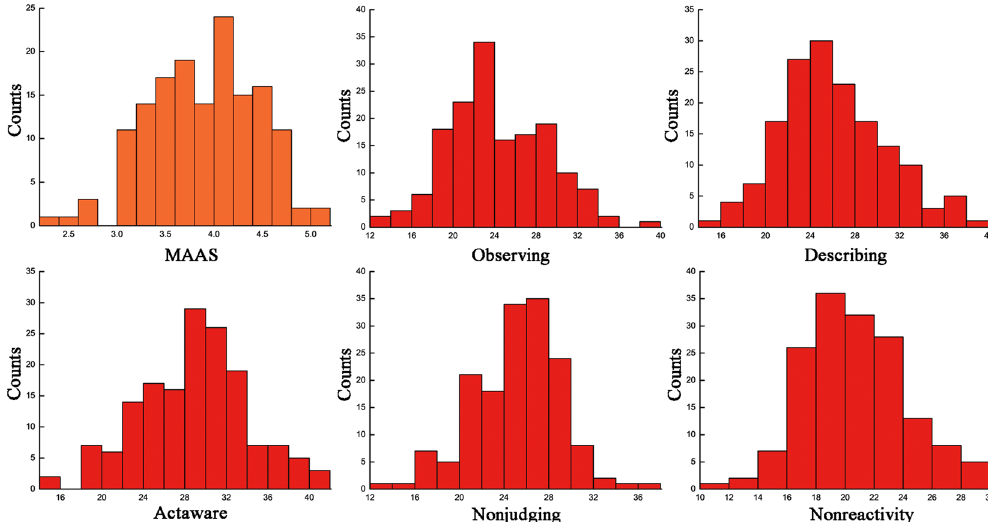
Figure 1. Distribution of the scores from MAAS and the five dimensions of FFMQ in our